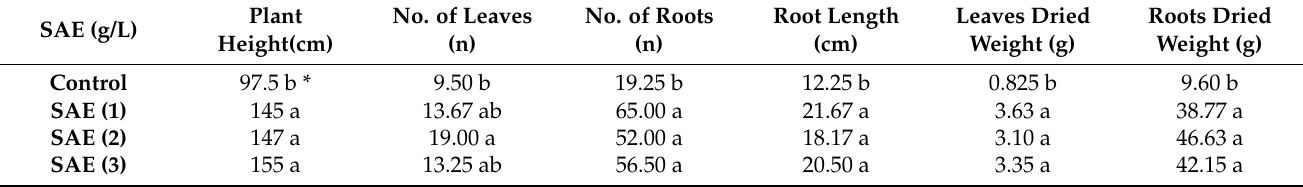
Table 5. Effects of Spirulina platensis aqueous extract (SAE) treatments on the plant height (cm), number (n) of leaves and roots, dried weight (g) of leaves and roots of C. longa .